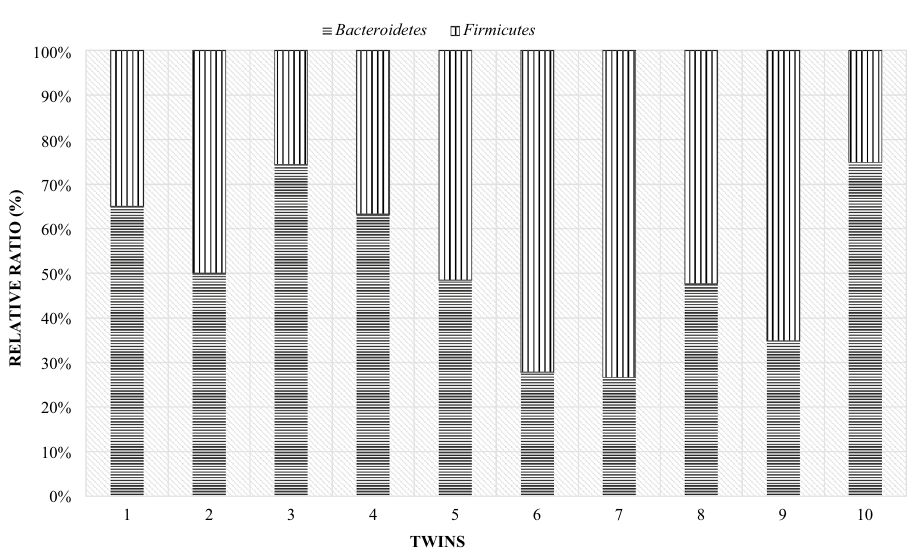
Figure 20. Relative ratio (%) of Firmicutes and Bacteroidetes phylum at 56 days of age in